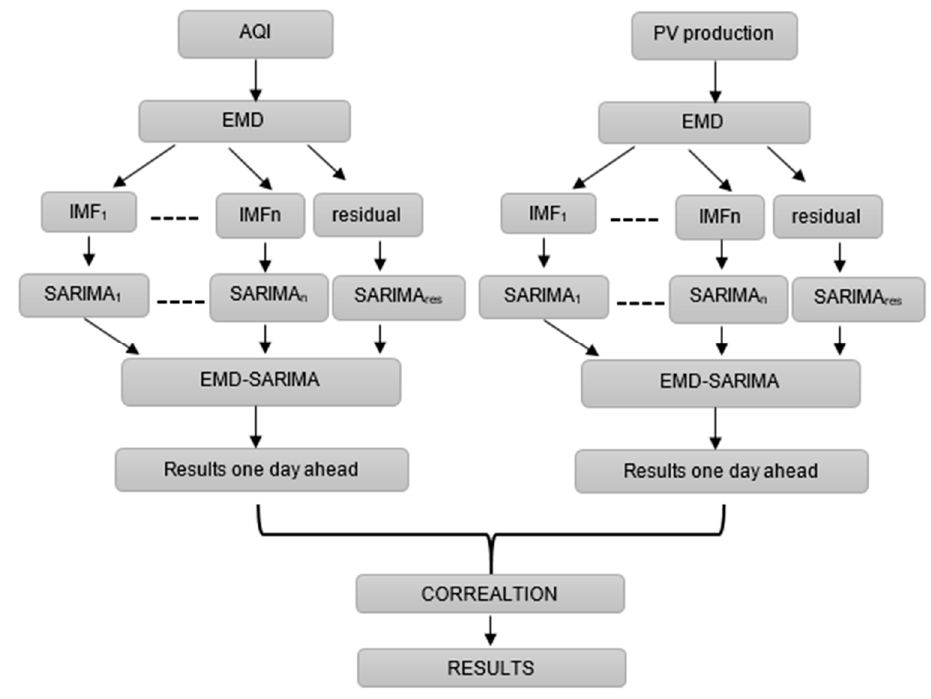
Figure 5. The procedure of the EMD-SARIMA modeling frame.